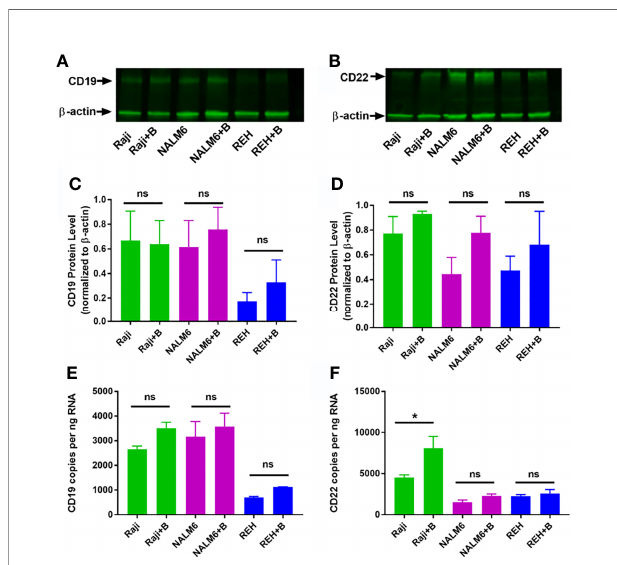
FIGURE 2 | Total RNA and protein levels of CD19 and CD22 in bryostatin treated leukemia cell lines. Western blot analysis of (A) CD19 and (B) CD22 protein expression in Raji, NALM6 and REH cell lines with (+B) or without bryostatin treatment. (C) CD19 and (D) CD22 band intensity from three independent experiments was quanti fi ed and normalized to b -actin. For each line, treated and non-treated groups were compared. There was no signi fi cant difference (ns) between groups of at the protein level. RNA levels for (E) CD19 and (F) CD22 were quanti fi ed by ddRT-PCR. CD19 and CD22 copies per ng RNA were calculated and analyzed. Signi fi cant differences between treated and untreated groups were seen for CD22 in Raji cells ( p < 0.05 ). *p < 0.05. ns, not signi fi